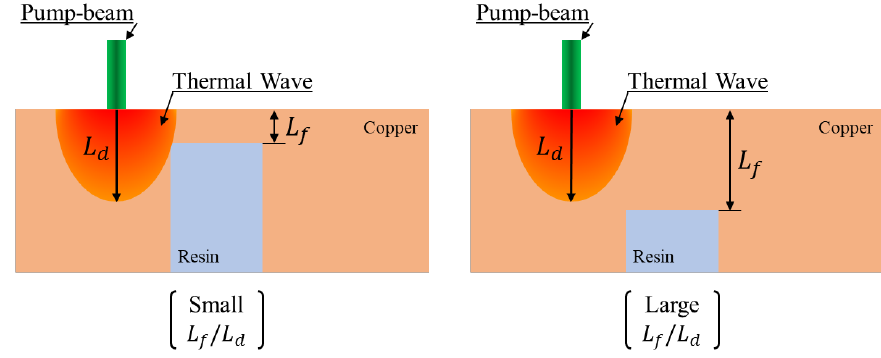
Figure 12. Physical phenomena depending on 𝐿 𝑓 /𝐿 𝑑 .